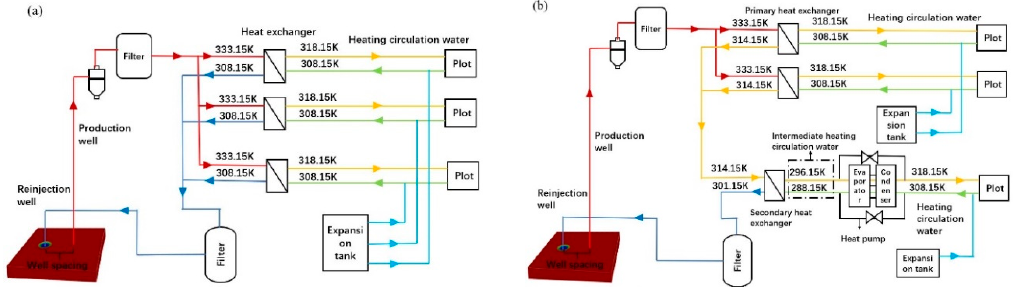
Figure 2. Operation strategies of geothermal heating systems: ( a ) direct geothermal district heating system (DGDHS) and ( b ) indirect geothermal district heating system (IGDHS).